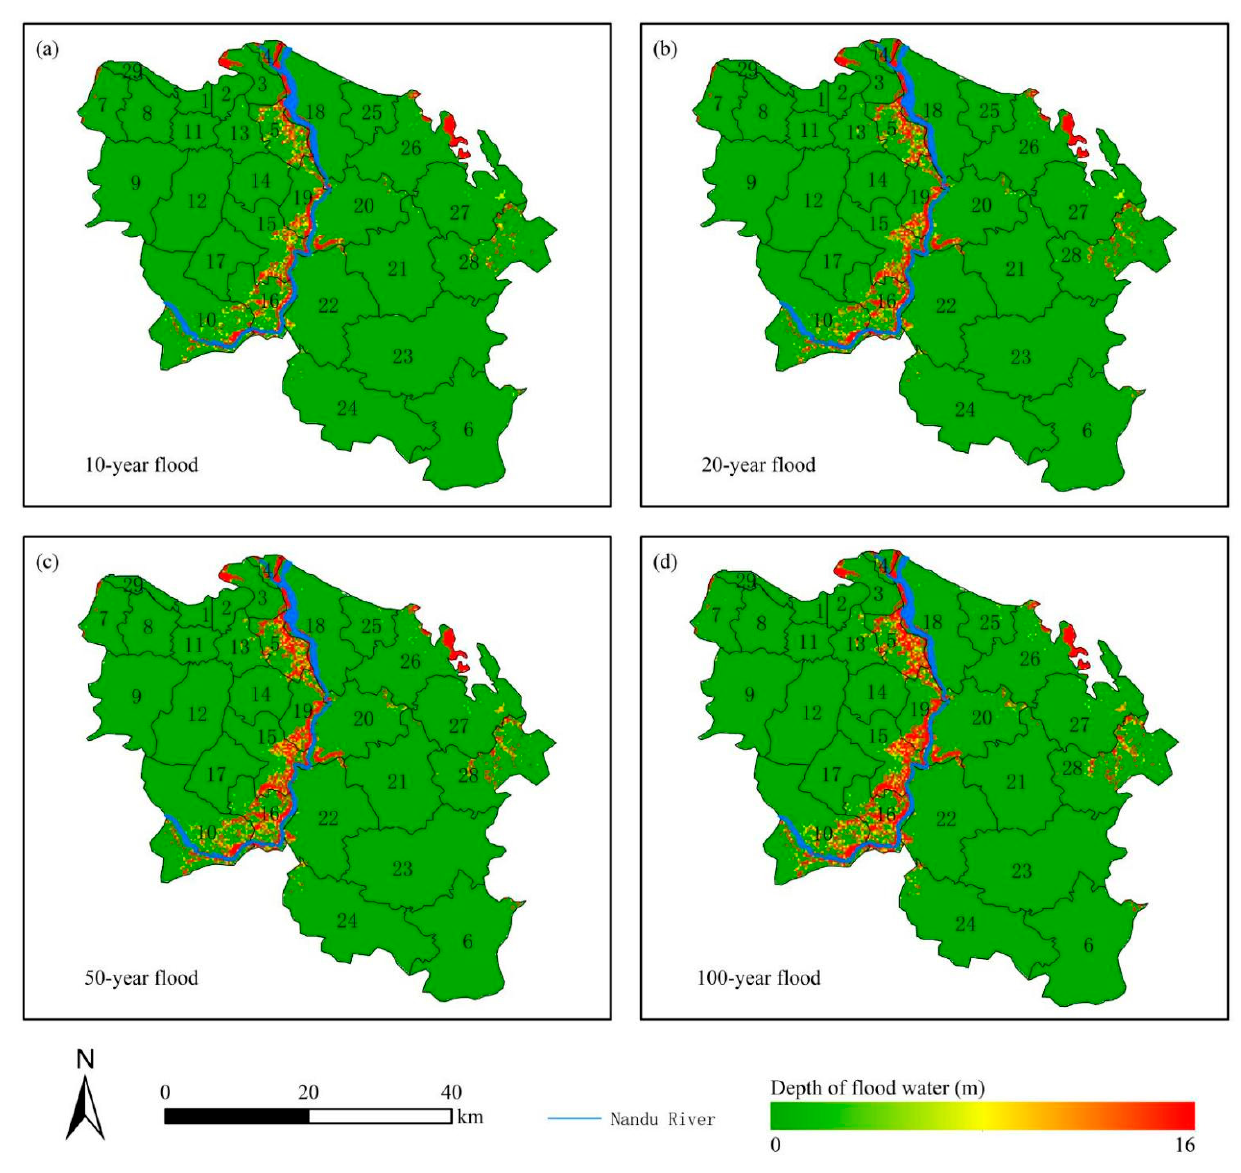
Figure 2. Immerged depth of floods in different return periods in Haikou City. ( a ) 10-year, ( b ) 20-year, ( c ) 50-year ( d ) 100-year. Note: The numbers represent assessment units.